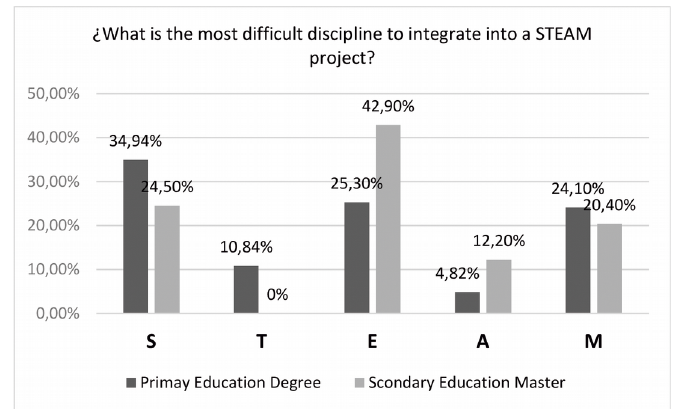
Figure 3. Difficulties in integrating the STEAM